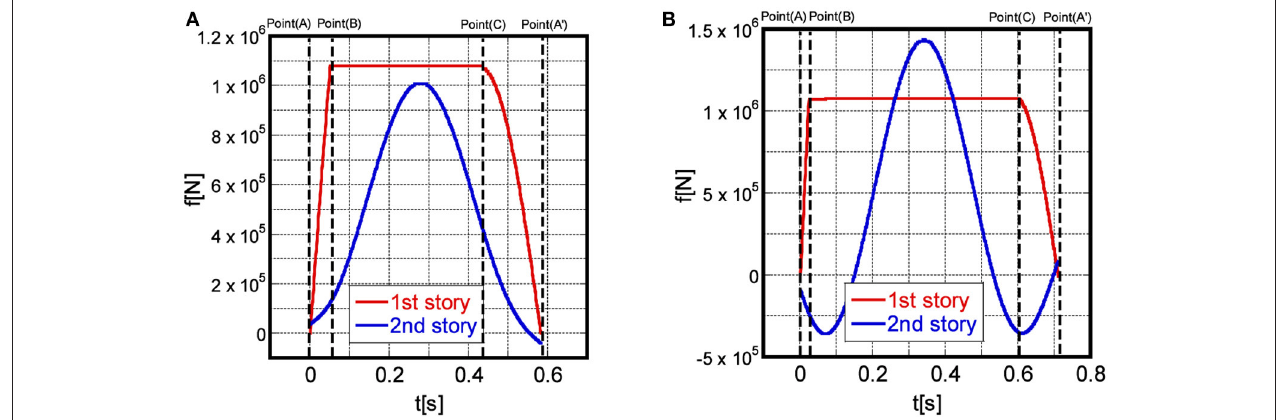
FIGURE 7 | Time histories between Point (A) and Point (A ′ ) of restoring force of first and second stories under critical multiple impulse with V = 0.1, 0.3[m/s], (A) V = 0.1[m/s], (B) V = 0.3[m/s].